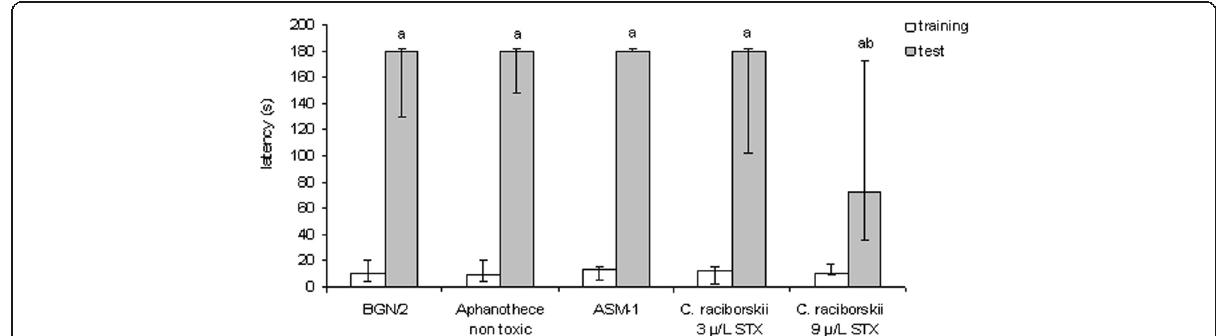
Fig. 4 Effect of consumption of cyanobacteria-contaminated drinking water in the step-down IA task. Data expressed as median and interquartile intervals (training session in white; test session in gray); n = 10 rats per group. Kruskal-Wallis test shows no significant difference among training session latencies ( p > 0.05). a Each of the five experimental groups has shown a significant difference between training and test session latencies ( p < 0.05, Wilcoxon test). b Only the PST-producing C. raciborskii (9 μ g/L STX equivalents) group showed a significant difference in the test session latency compared to the control group ( p < 0.05, Dunn test)